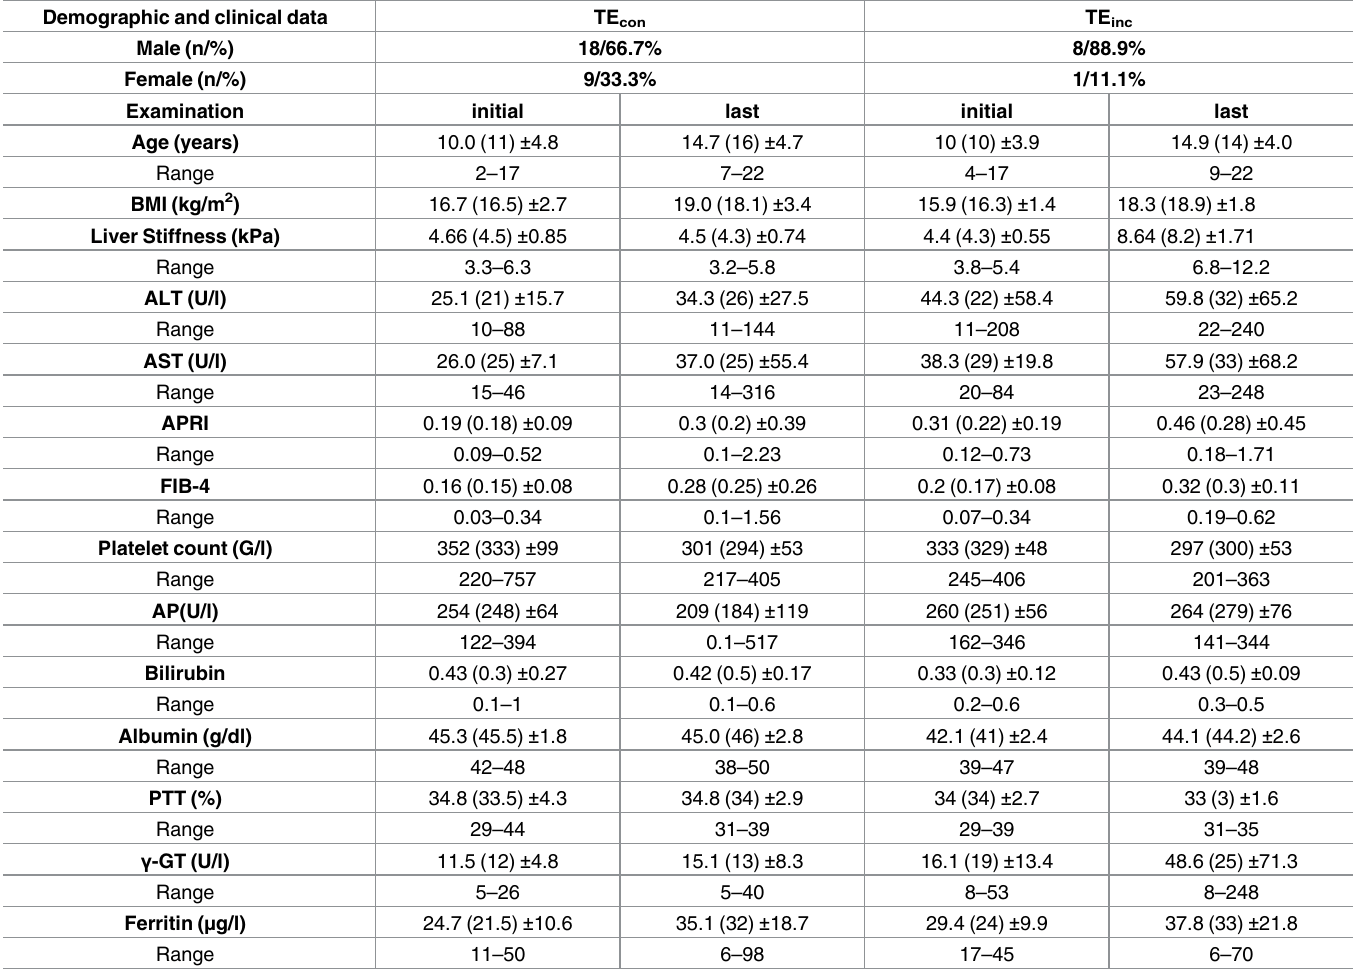
Table 1. Demographic and clinical data of the pediatric cystic fibrosis patient